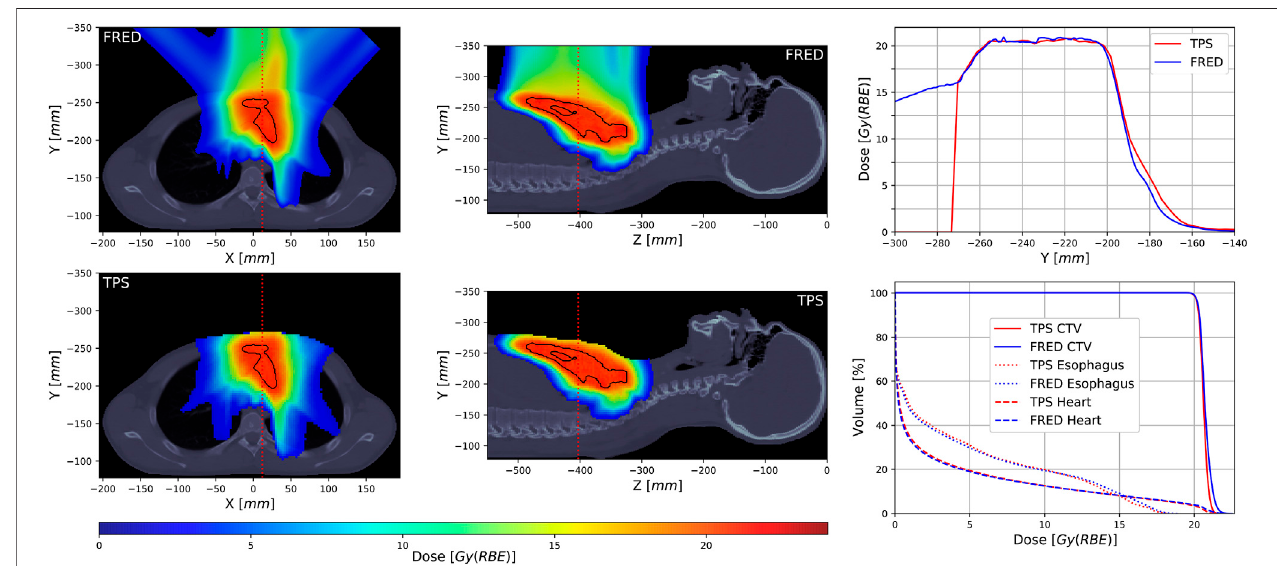
FIGURE 9 | Dose distribution example (left and middle columns) of a patient treatment plan calculated with F RED MC (upper row) and the TPS (lower row) with a clinical target volume (CTV) structure marked with the black line, dose pro fi les (upper right) along the red dotted line indicated on the dose distribution panels, and comparison of dose volume histograms calculated for CTV and two selected organs at risk (lower right) .